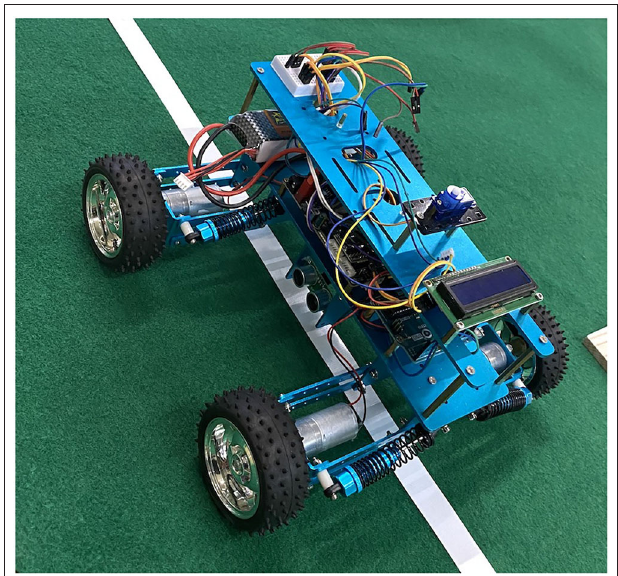
FIGURE 12 | Intelligent agricultural robot, with infrared distance measurement and multiple cameras deployed on the bottom.